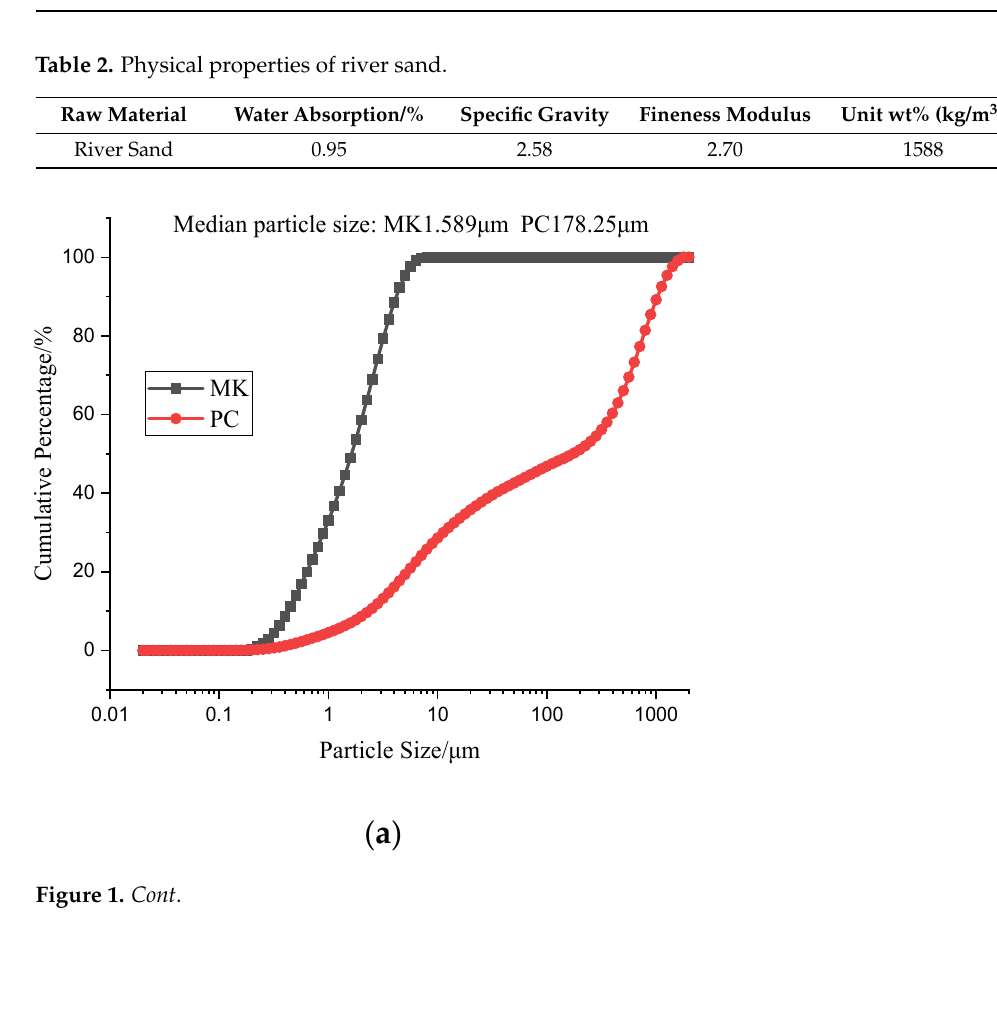
Table 1. Chemical compositions of Portland cement and Metakaolin/%. Table 2. Physical properties of river sand.